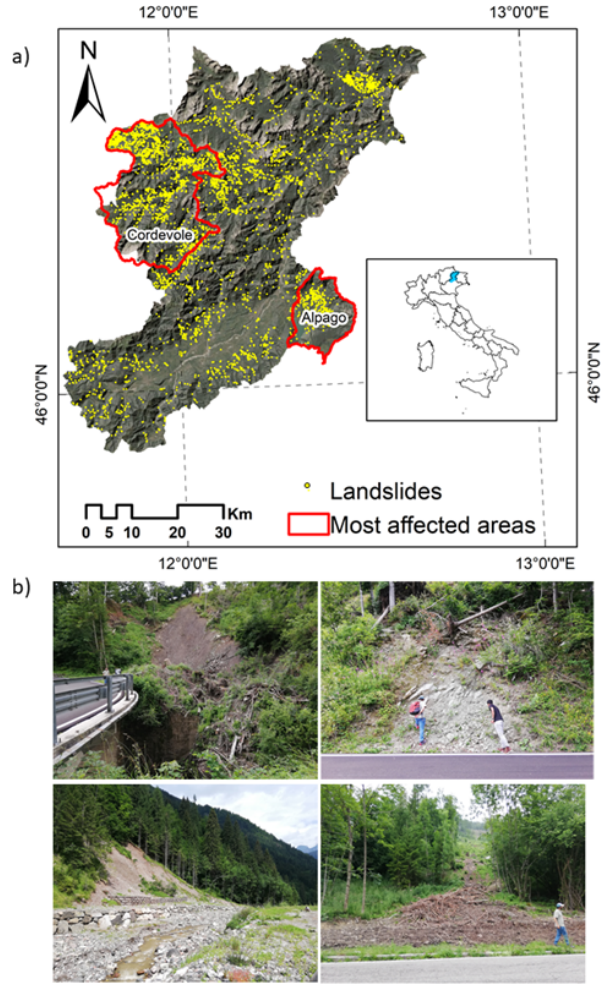
Figure 1. (a) Location of the study area and landslides collected by the IFFI (Inventory of Landslide Phenomena in Italy) project. (b) Field photographs after the Vaia